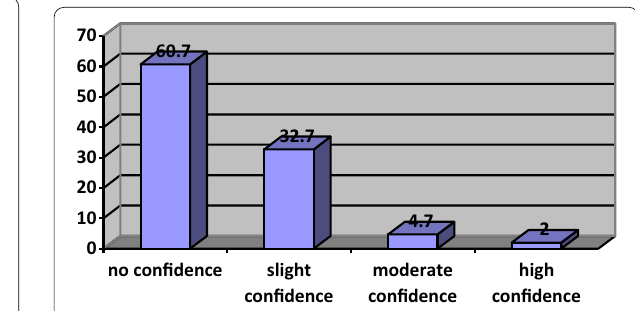
Fig. 9 Confidence to pay household